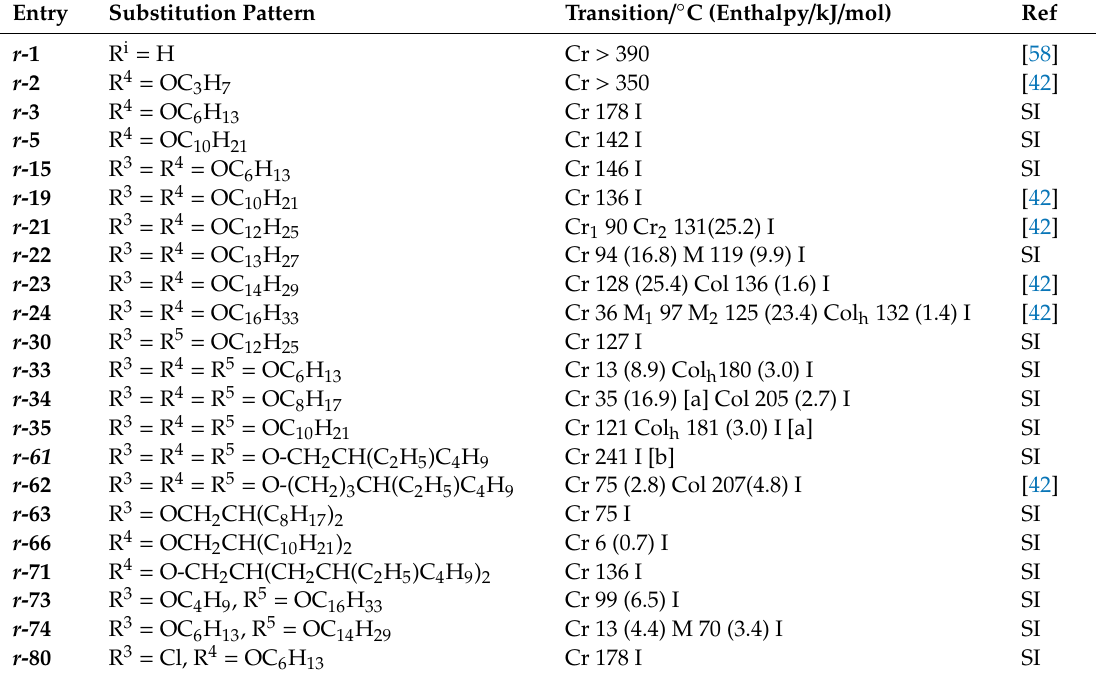
Table 4. Substitution pattern of r -TTTs and thermal